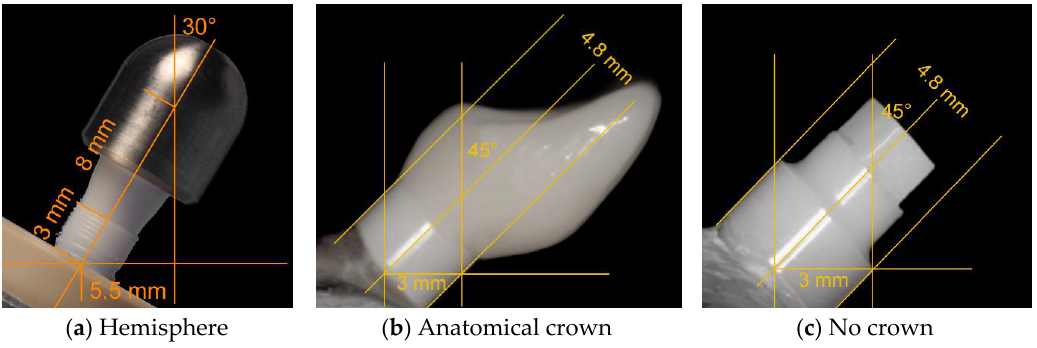
Figure 11. Exemplary schemes of embedded implants according to ISO 14801 ( a ) [21], equipped with an anatomically shaped incisor crown ( b ) or without any restorative supply ( c ) [20]. When embedding the samples according to ISO 14801, the lever arm measures 5.5 mm. In the latter two cases, the lever arm needs to be individually calculated and